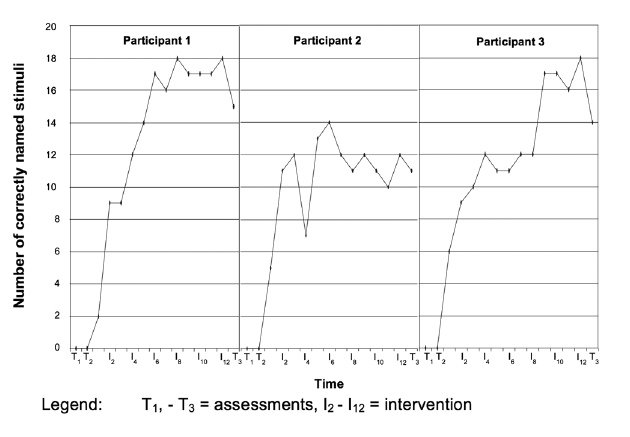
Figure 4: Confrontation naming (Block A) throughout the treatment